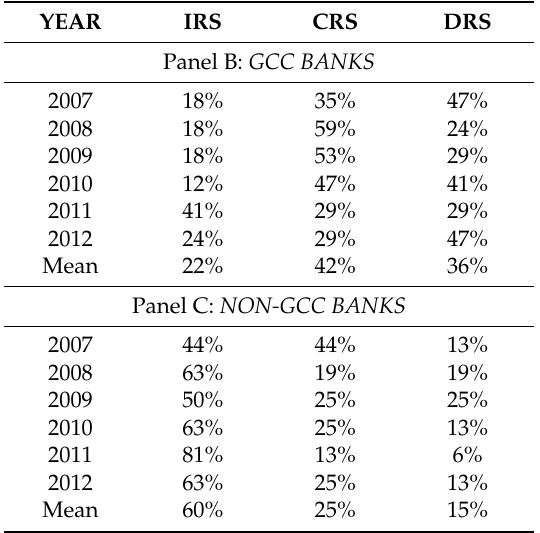
Table 4. Percentage of Islamic banks by nature of returns to scale between 2007 and